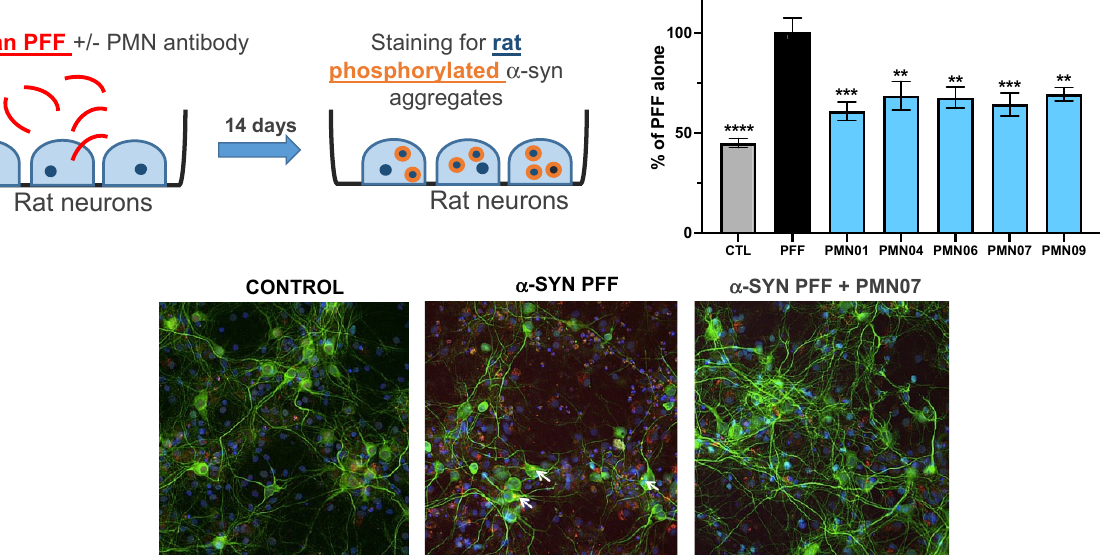
Figure 11. mAb inhibition of the recruitment of endogenous rat α -syn into phosphorylated aggregates. Cultures of primary rat hippocampal neurons were exposed to sonicated human PFF (1 µ g/mL) without or with mAbs (0.05 µ M, except for PMN09 at 0.25 µ M). CTL = neurons incubated with vehicle alone. Cultures were stained 14 days later for neuronal marker MAP2 ( green ), aggregates of phosphorylated rat α -syn ( red ) and cell nuclei ( blue ). Results are expressed as a percentage of the phosphorylated rat α -syn staining area with PFF alone and show the mean + SEM of 6 repli- cate cultures. A global analysis of the data was performed using one-way ANOVA followed by Dunnett’s multiple comparisons test. ** p ≤ 0.01, *** p ≤ 0.001, **** p ≤ 0.0001 vs. PFF.